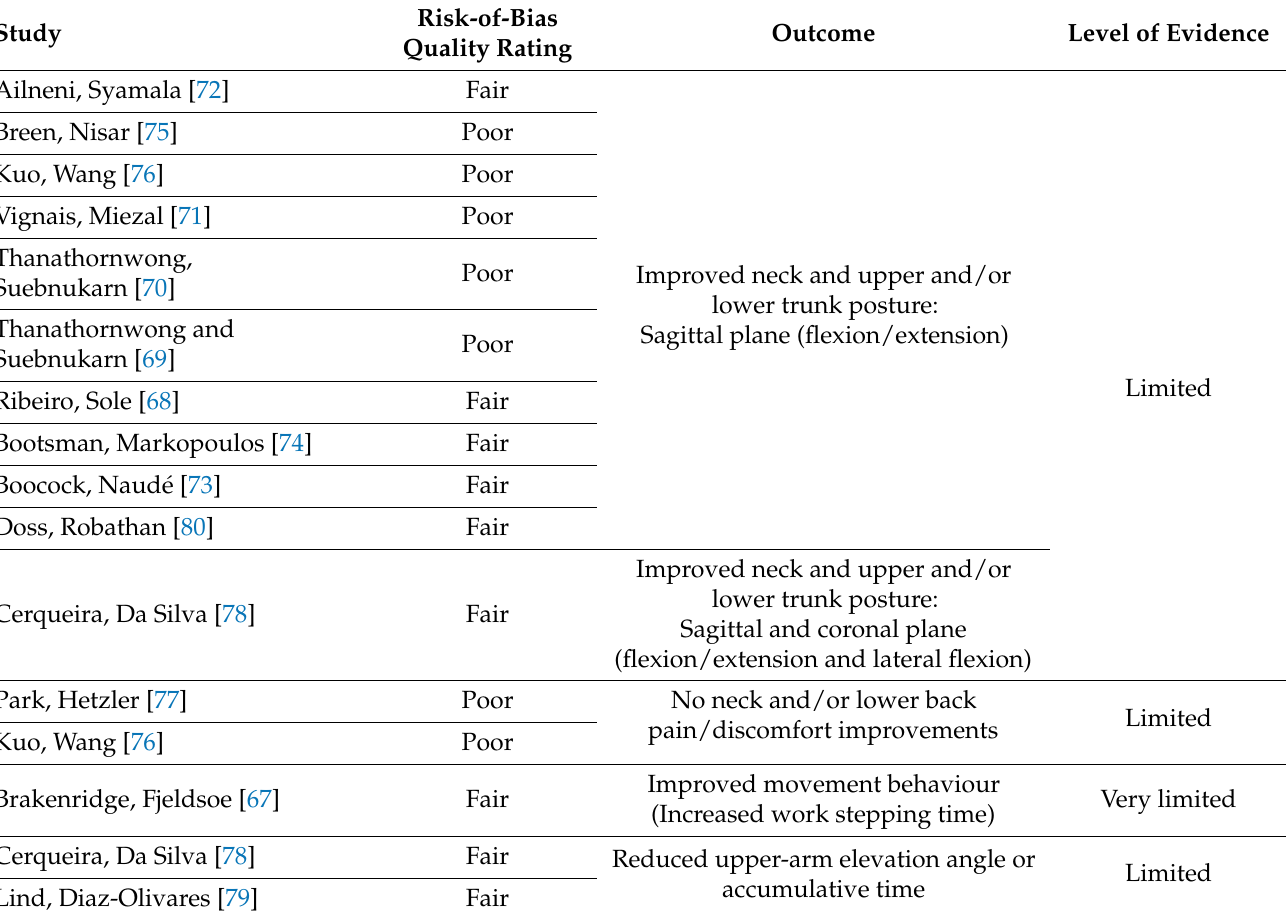
Table 9. Evidence for changes in posture and movement behaviour during work or performing work-related activities. Risk-of-Bias Study Outcome Level of Evidence Quality Rating Ailneni, Syamala [72] Fair